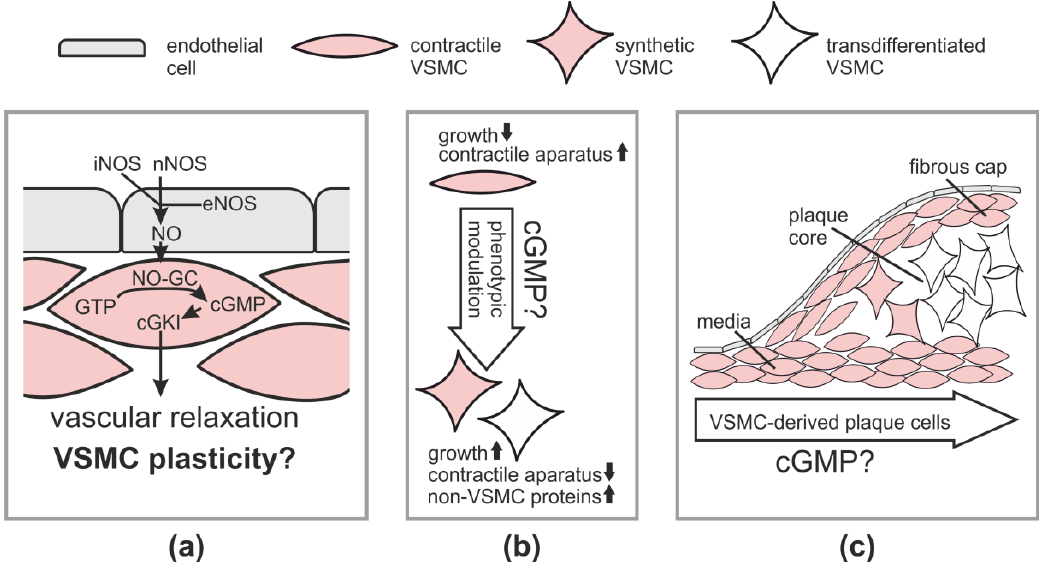
Figure 1. cGMP signaling and vascular smooth muscle cell (VSMC) plasticity. ( a ) The canonical NO-cGMP-cGKI pathway in the vessel wall; ( b ) Concept of VSMC plasticity and ( c ) VSMC-derived cells and VSMC transdifferentiation in atherosclerotic plaques and potential role of cGMP. Note that monocyte-derived macrophages and other plaque cells are not shown. For further explanations, see main text. eNOS, endothelial NO synthase; iNOS, inducible NO synthase; nNOS, neuronal NO synthase.